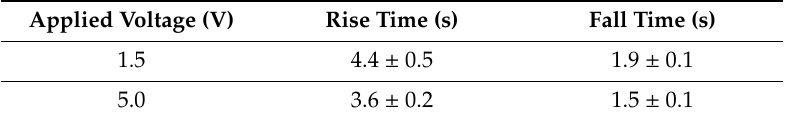
Table 1. UV sensor response times for 1.5 V and 5 V applied between the